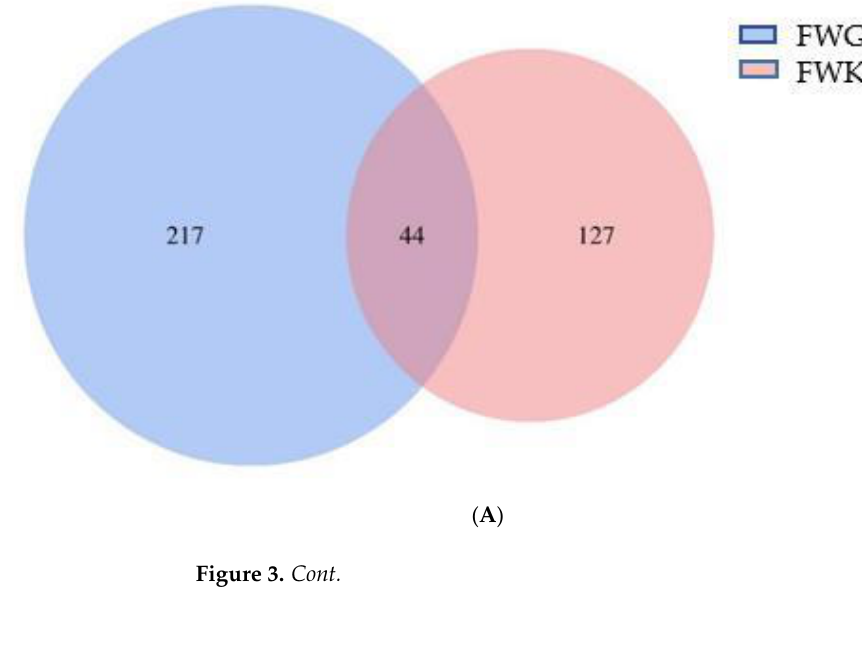
3.3.2. Functional Annotation of Differentially Expressed Genes (DEGs) P- adjust < 0.05 and log2(foldchange) ≥ 1 were used to identify DEGs with significant differences. FWK groups versus BWK groups had 432 DEGs between them compared to FWG vs. BWG (Figure 3A), including 171DEGs in gill (57 upregulated and 114 downreg- ulated) and 261 DEGs in kidney (178 upregulated and 83 downregulated) (Figure 3B).